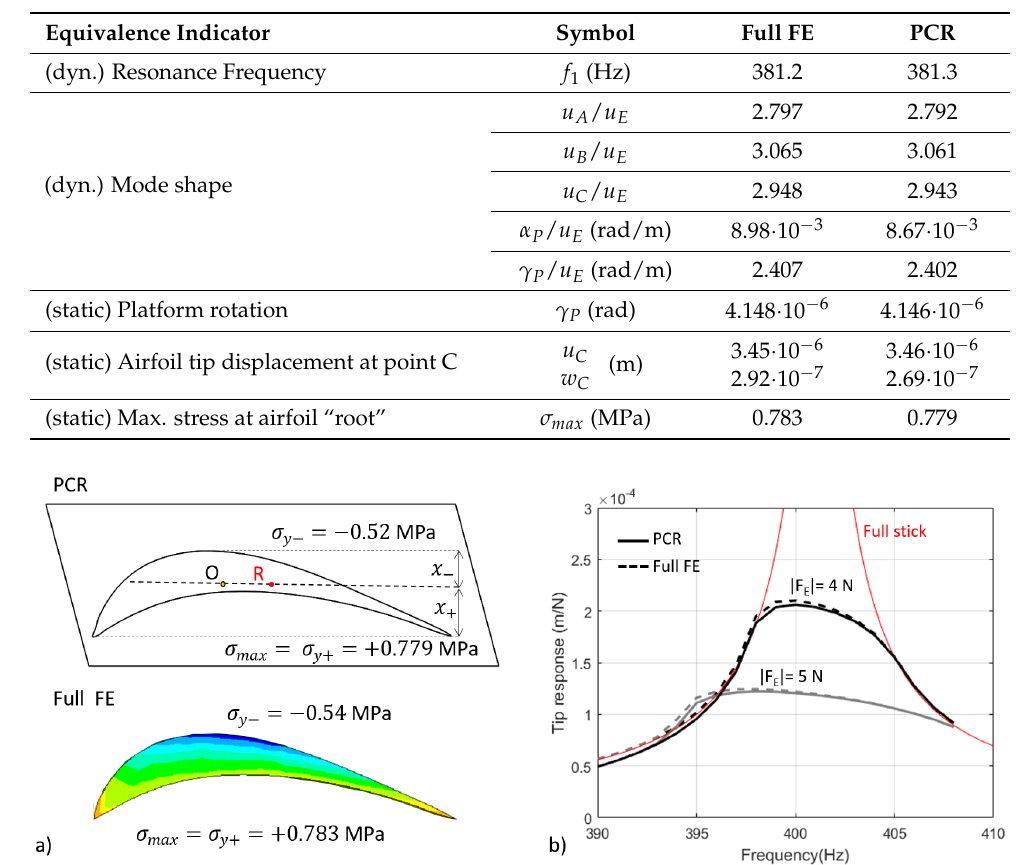
Table 1. Comparison between the Full FE and the PCR freestanding blade models for the smaller Blade A (see Section 3). Static analysis results refer to a unit force F E applied at point E along the x -axis. Modal analysis results refer to the first bending mode.